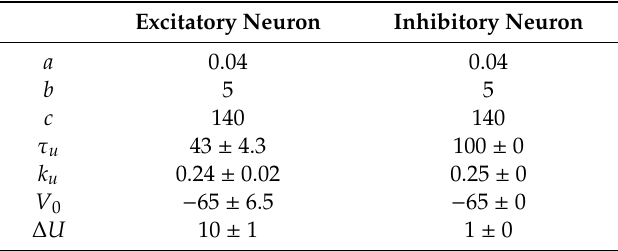
Table 1. Parameter values of the neuron